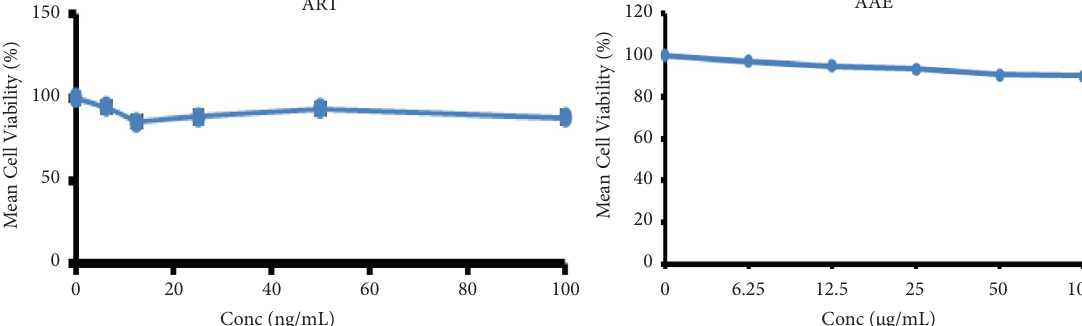
Figure 1: Erythrocytes’ survival after exposure to the crude extract of A. africana (AAE) and artesunate (ART). Cytotoxic efects (CC values) of AAE and ART are greater than 100 μ